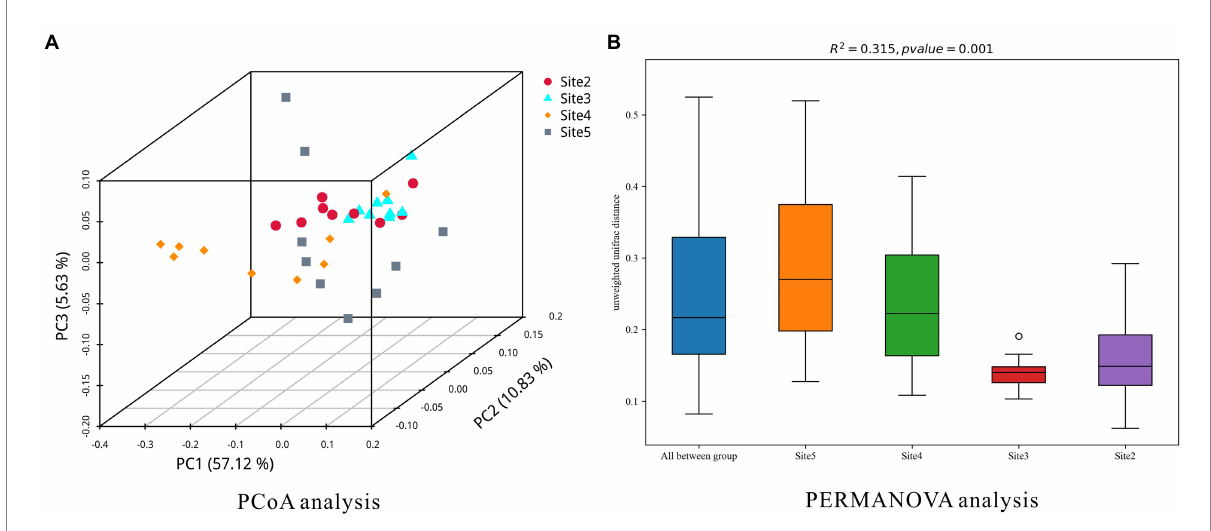
FIGURE 4 The dissimilarities of the microbial community at each sampling